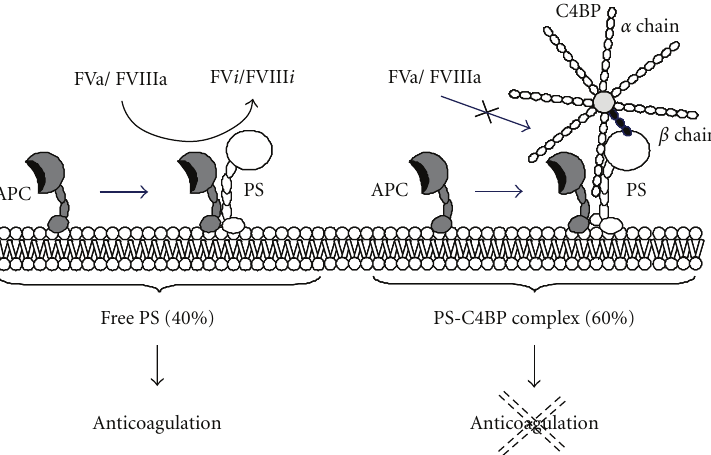
Figure 2: Functions of PS and PS-C4BP complex . PS circulates in free form (about 40%) and in complex form with C4BP (about 60%) in plasma. C4BP is comprised of seven α chains and a β chain, and PS binds to the β chain. APC proteolytically converts factors Va and VIIIa (Va/VIIIa) into inactivated factors Va and VIIIa (V i /VIII i ) in the presence of free form PS, but not the complex form PS with